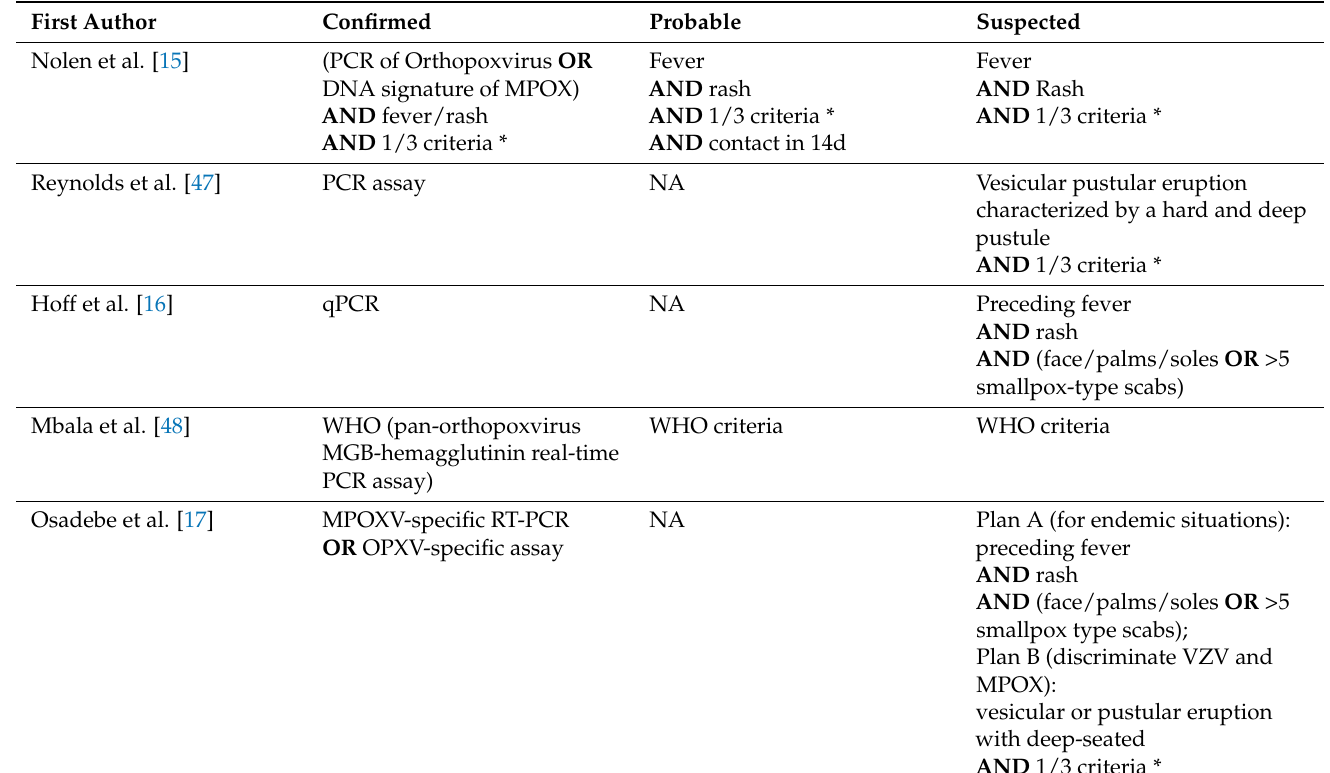
Table 3. Confirmed, probable, and suspected case definitions of the included studies (only available data are mentioned), compared to WHO and CDC case